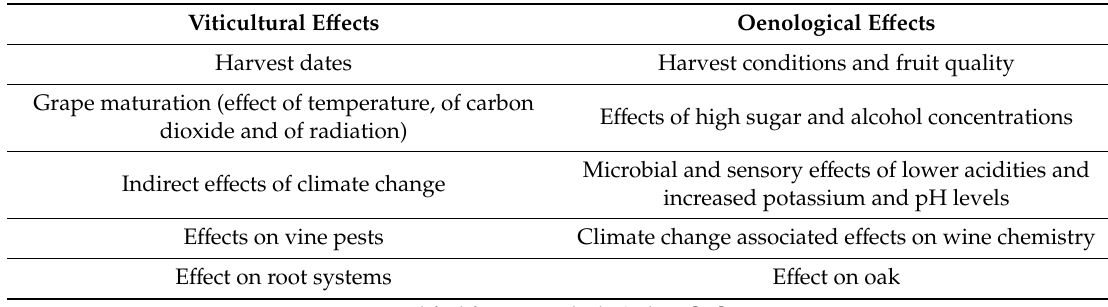
Table 1. A list of the e ff ects of climate change on viticulture and enology. Often, oenological e ff ects are a consequence of viticultural e ff